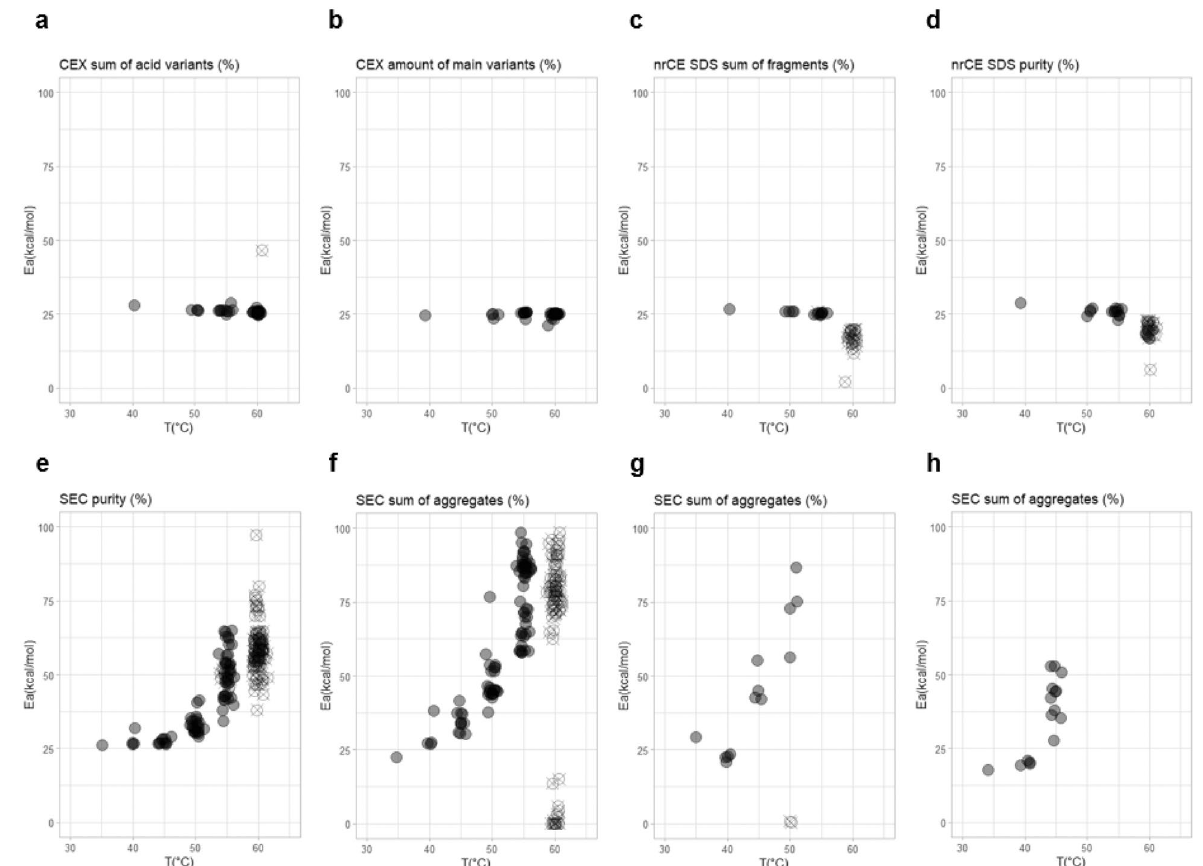
Figure 4. Robustness of kinetic model by the analysis of temperature sub-sampling of accelerated stability data. Each circle represents calculated E a (on y-axis) and the highest temperature (on x-axis) for one subset. Each subset contains at least 3 different temperatures. Parameters E a are determined for all combinations of subsets for different quality attributes of one batch of mAb1 molecule (a–f) and for sum of aggregates for one batch of etanercept (g) and mAb2 (h) . Goodness of fit for each determined activation energy is colour-coded by the colour of the data points circles; grey circles indicate ( R 2 ≥ 0.9); crossed empty circles indicate R 2 <